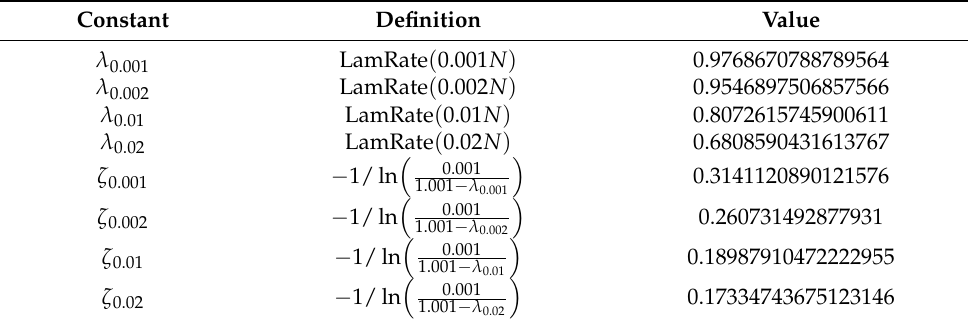
Table 1. Constants used in the specification of the Self-Tuning Lam, including the constant, its mathematical definition, and its double-precision floating point